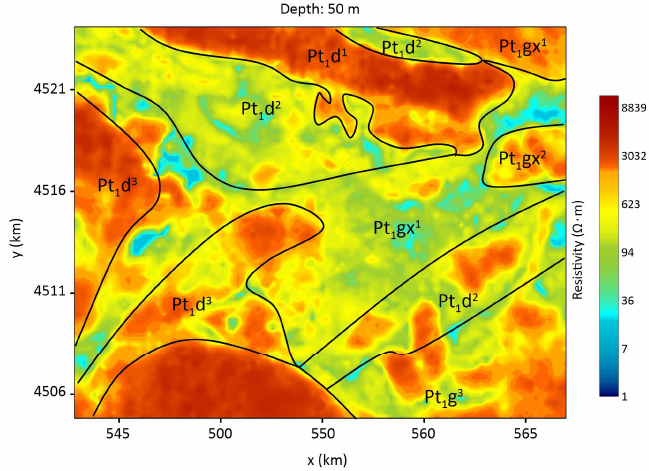
Figure 10. Main distribution of the different formations in the survey area inferred from resistivity model at a depth of 50 m.